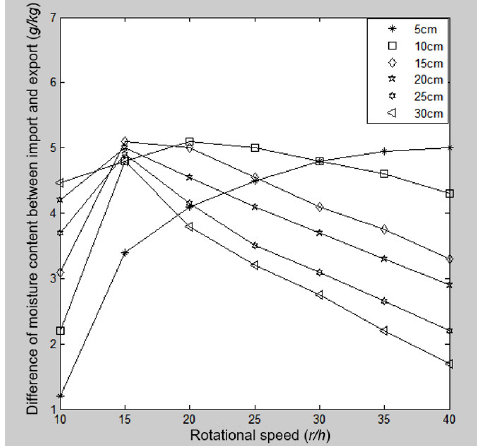
Figure 10. Effect of runner’s speed on adsorption performance.